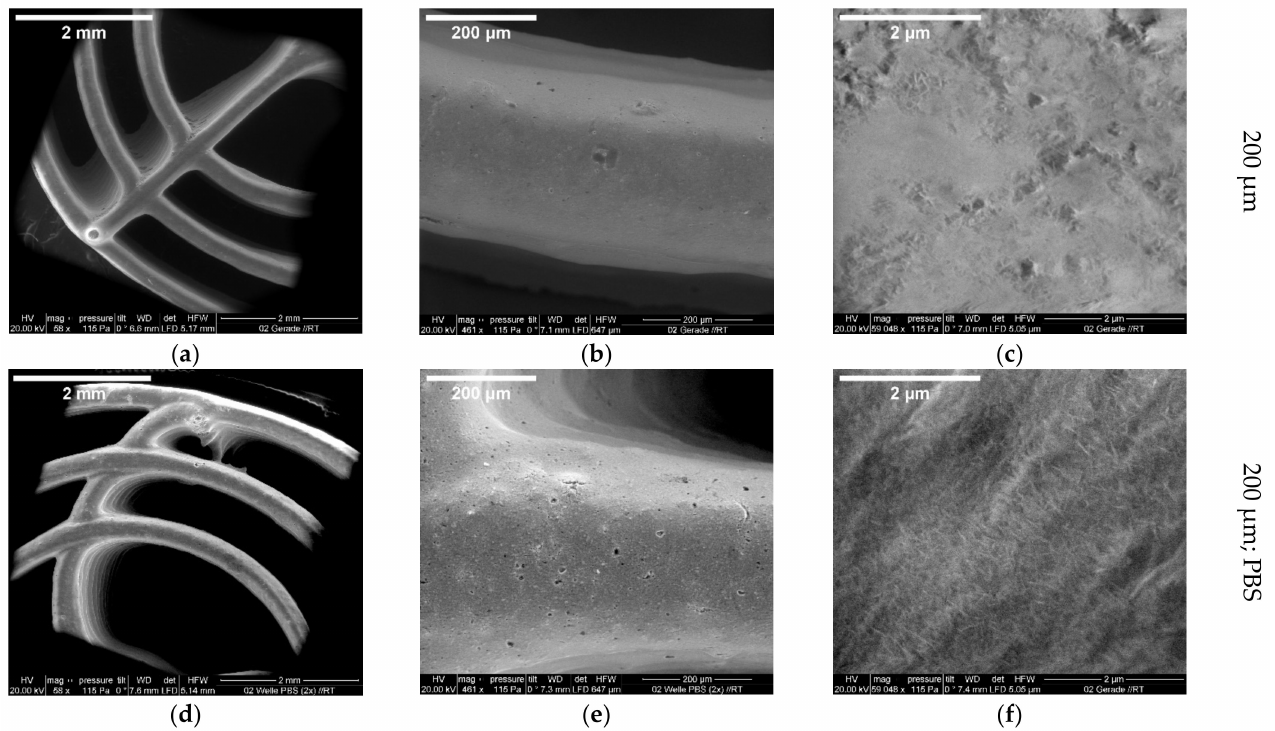
Figure 3. ESEM images of 3D-printed CPC scaffolds (200 µ m) at increasing magnifications for an untreated straight spoke ( a – c ) and a wavy spoke after incubation for 1 week in PBS ( d – f ); images taken with an FEI Quanta FEG 250 ESEM with large field detector and 20 kV acceleration voltage at 115